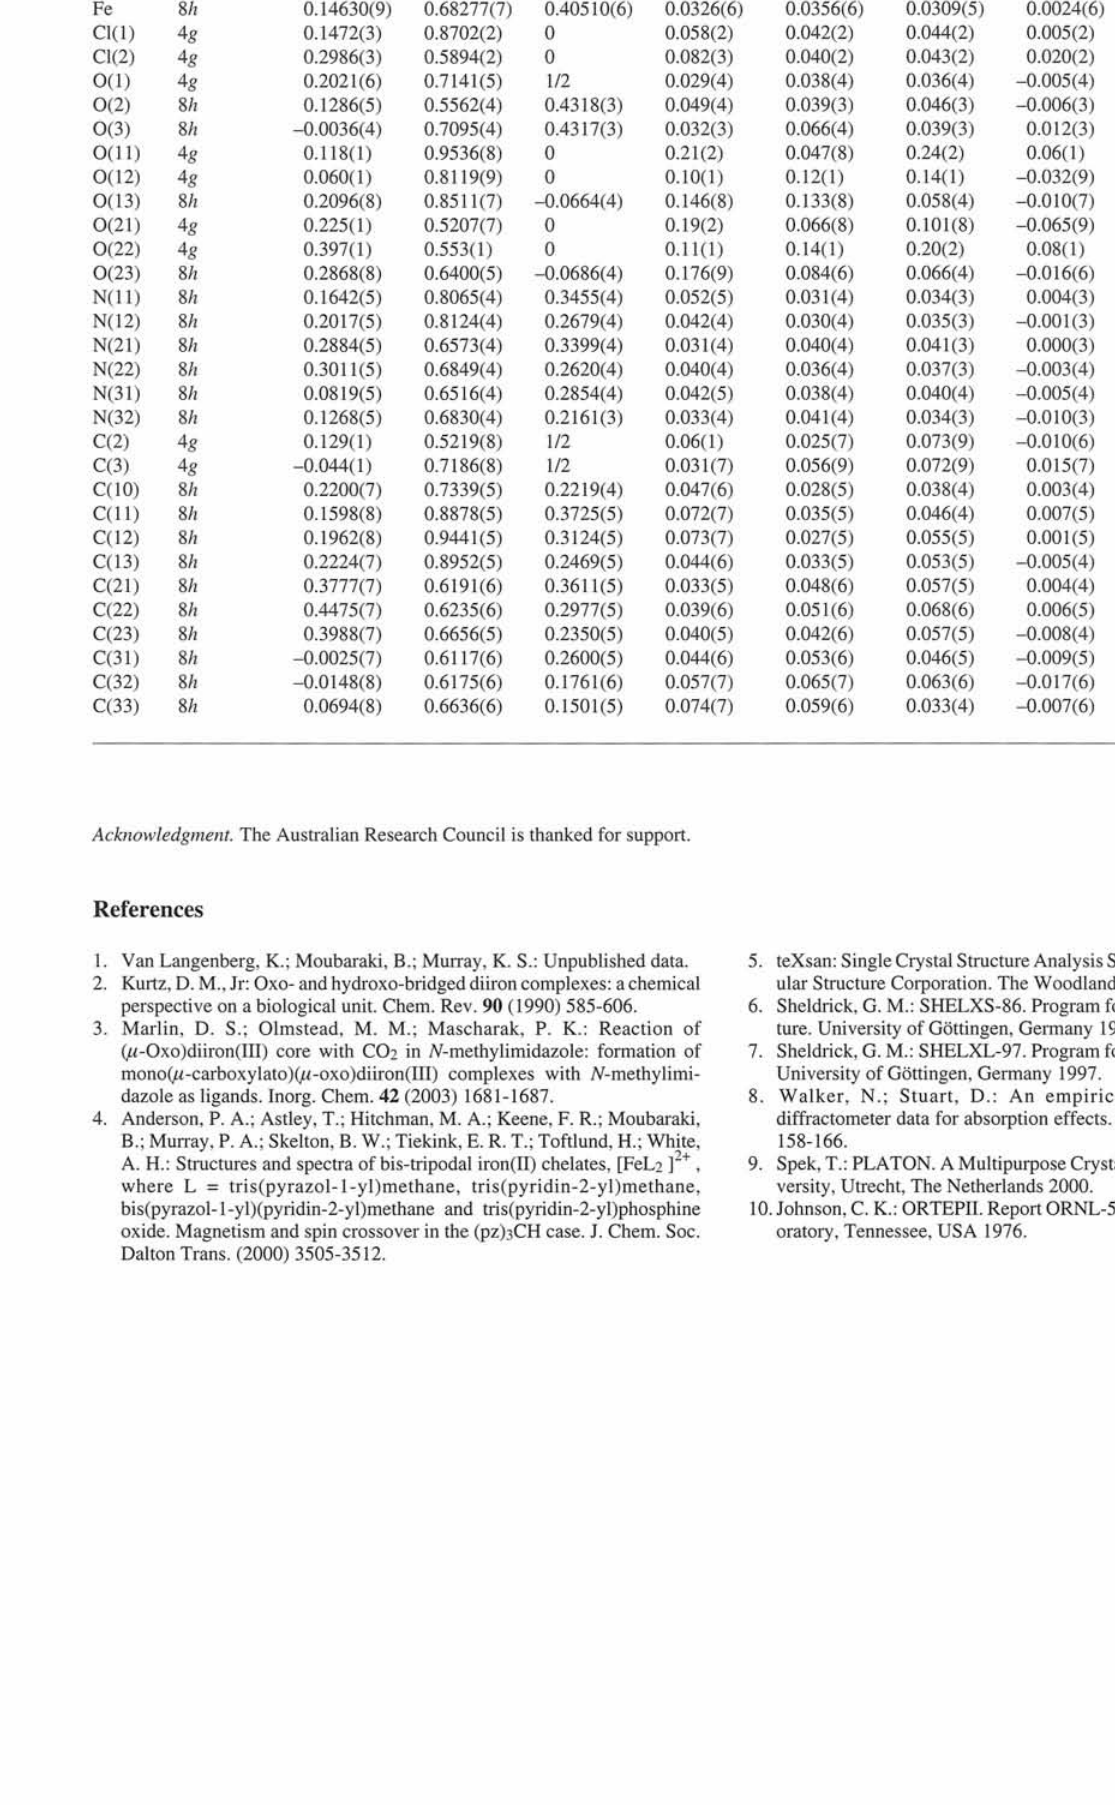
Table 3. Atomic coordinates and displacement parameters (in A 2 ).